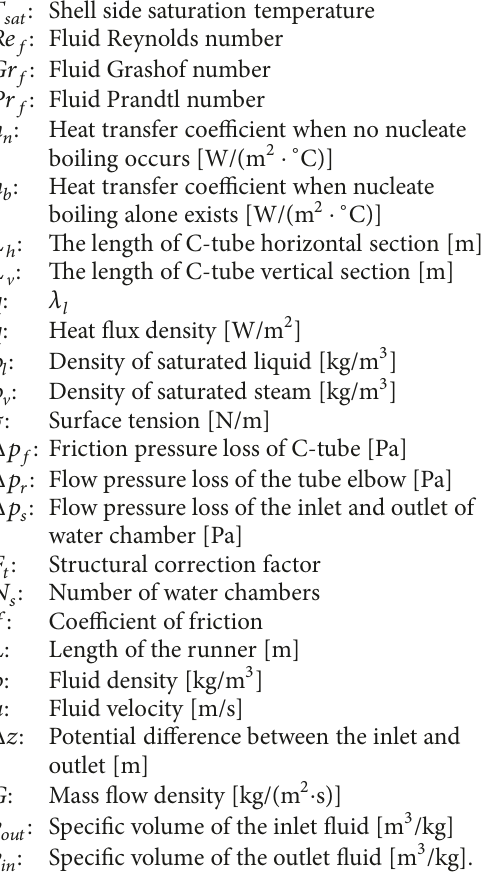
The algorithm test results and optimal schemes of